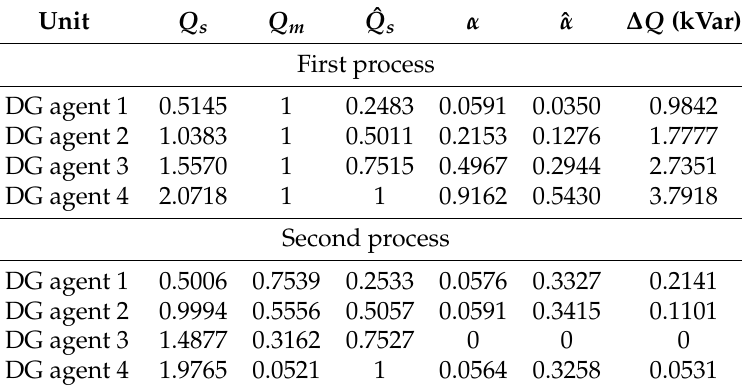
Table 3. The simulation results for Case